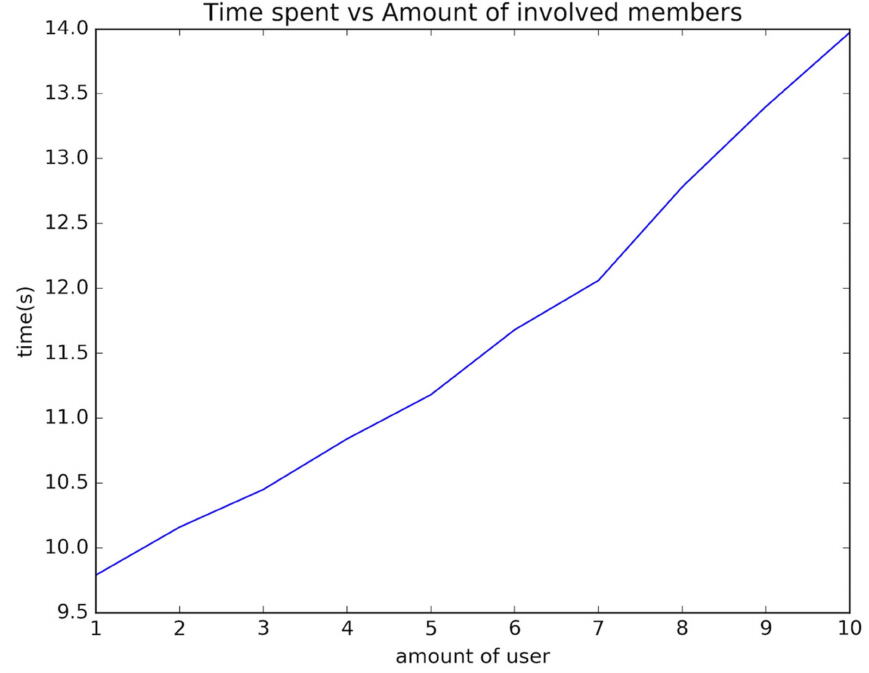
Figure 8. Our system response time versus the number of concurrent system